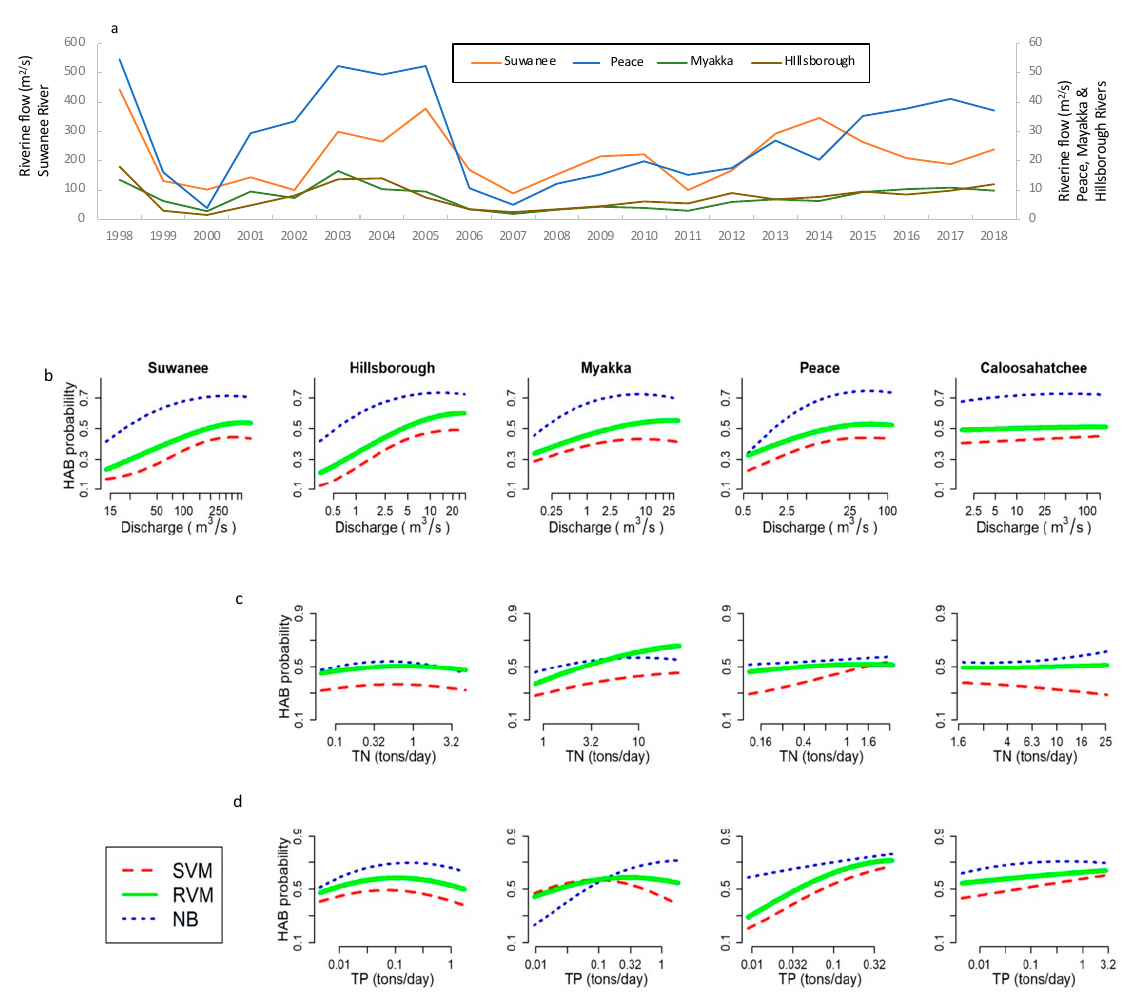
Figure 7. ( a ) Annual mean riverine flow for rivers indicated for the 21 year time series. ( b ) Probability of K. brevis blooms as a function of riverine discharge. ( c , d ) Probability of K. brevis blooms as a function of total nitrogen loading (TN) and total phosphorous loading (TP). Probabilities were obtained from three machine learning models: RVM (thick green lines); NB (dotted blue lines); SVM (dashed red lines).